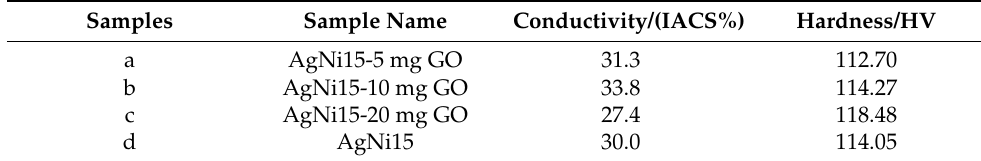
Table 1. Conductivity and hardness of the